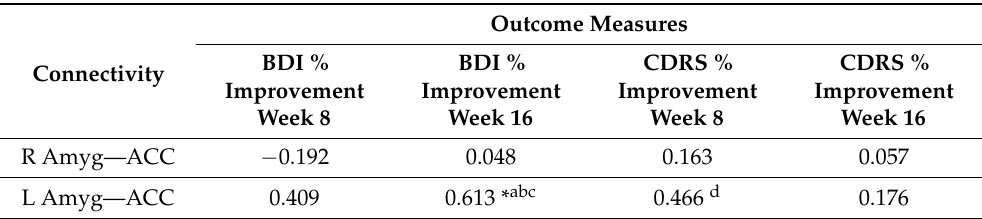
Table 3. Results (standardized Beta coefficients) of linear regression analyses modeling resting state functional connectivity as a predictor of clinical outcomes.